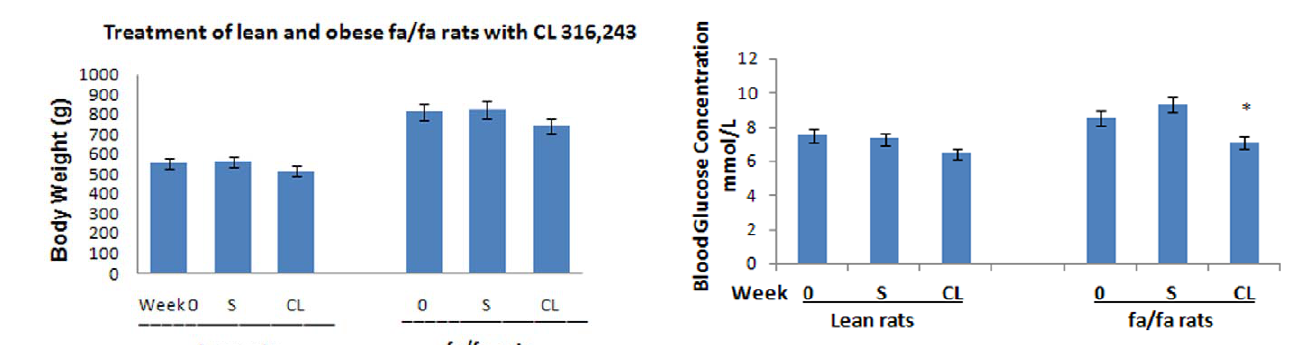
Table 1. Body weight and retroperitoneal WAT (RWAT) measurement in rats.